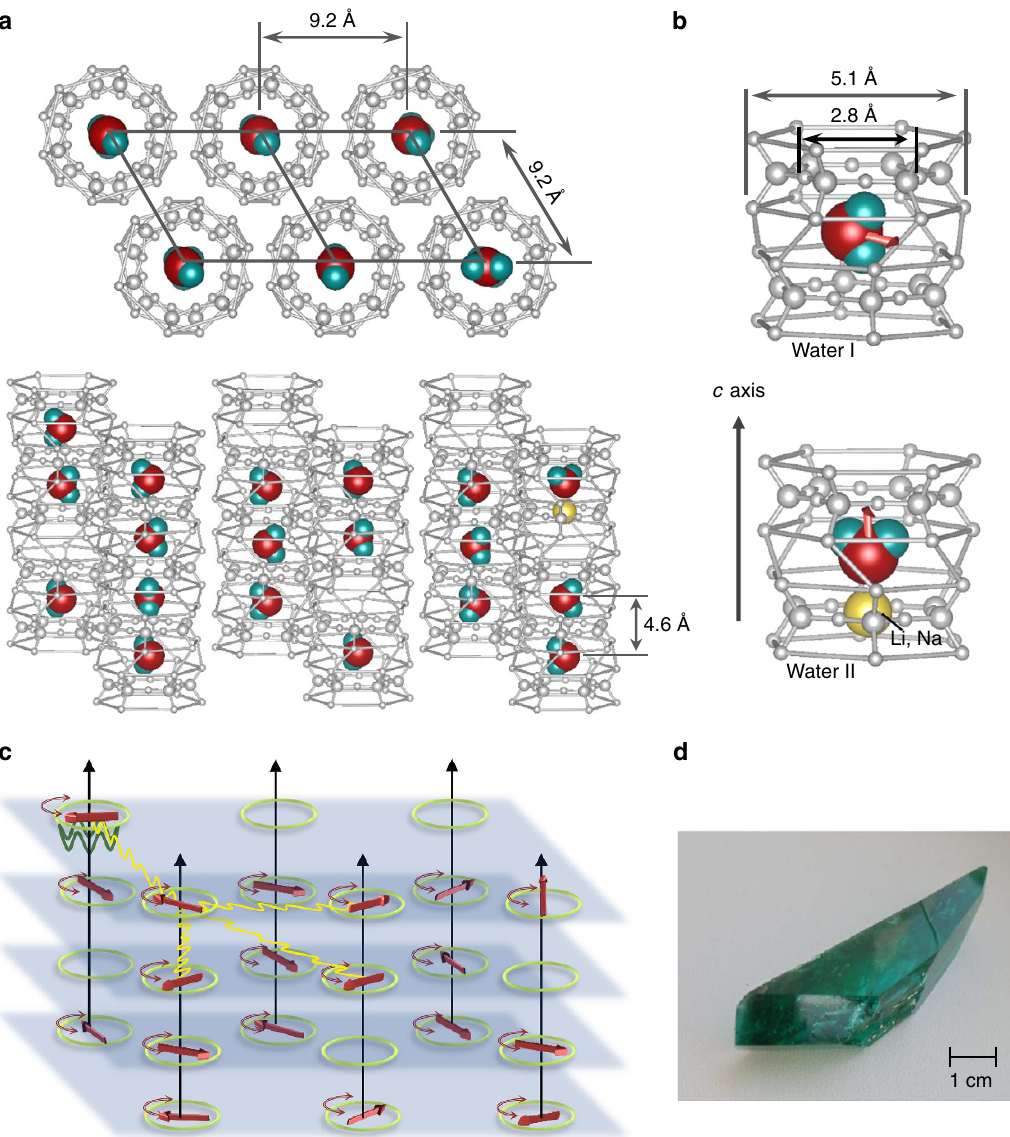
Figure 1 | Schematic view of water molecules in nano-sized cages of the beryl crystal lattice. ( a ) Water molecules confined in the channels within the beryl crystal lattice. Three-dimensional and top views with the crystal plotted greyish and the water molecules coloured (oxygen red and hydrogen cyan). The 1D channels are arranged in a hexagonal fashion with 9.2Å distance and contain cages in a distance of 4.6Å. ( b ) Water molecules located within structural voids formed by lattice ions. The cages (diameter 5.1Å) are separated by narrower bottlenecks (2.8Å). Molecules of type I have their dipole moments (red arrows) perpendicular to the crystallographic c axis with the plane of H 2 O molecules parallel to c ; they can perform hindered rotations around the c axis experiencing a six-well potential (depth A ) due to the hexagonal crystal symmetry. Type II water molecules are turned by 90 (cid:2) relative to those of type I due to Coulomb interactions with alkali ions (Li and Na, shown in yellow) blocking the bottleneck; their dipole moments are directed along the c axis. ( c ) Dipole moments of type I molecules. The moments can rotate within the planes perpendicular to the c axis. The dipole–dipole interactions (yellow wavy lines) act between the molecular dipoles within the channels where molecular doublets, triplets and so on are formed; the interactions between dipoles in adjacent channels are much weaker owing to their greater mutual distances. ( d ) Photograph of the typical studied beryl